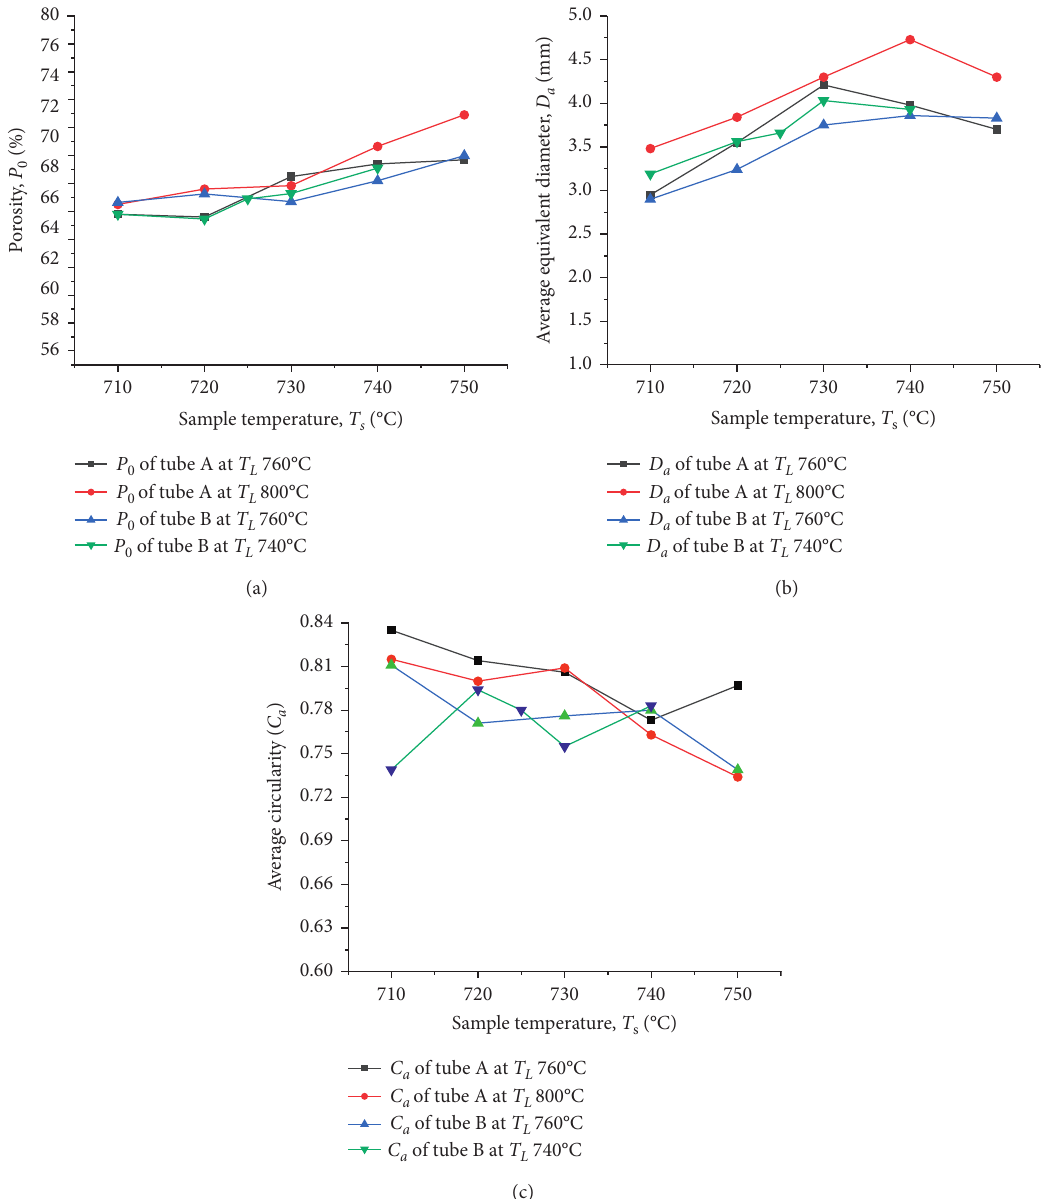
Figure 9: Comparison of pore structure parameters of samples in pipes A and B: (a) porosity, (b) average equivalent diameter, and (c) average circularity.